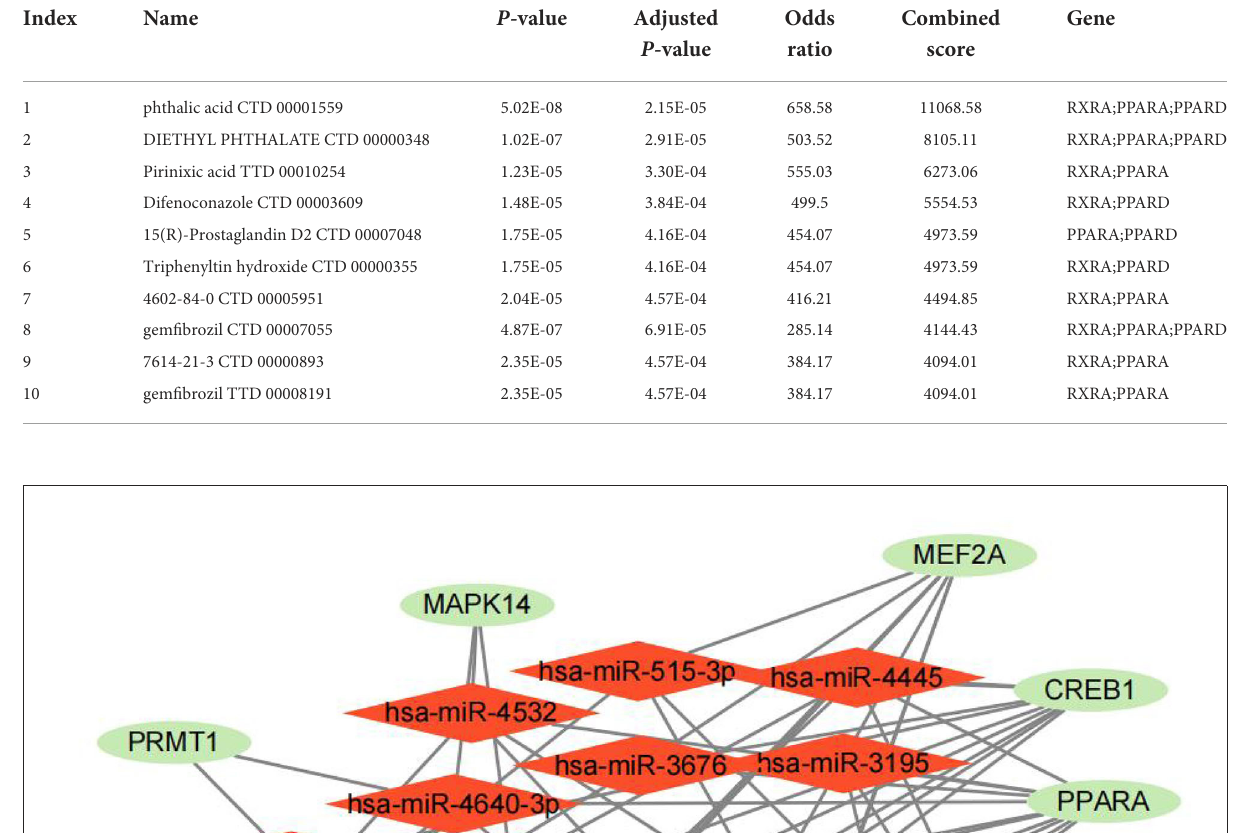
TABLE 1 The prediction of energy metabolism-related drugs.